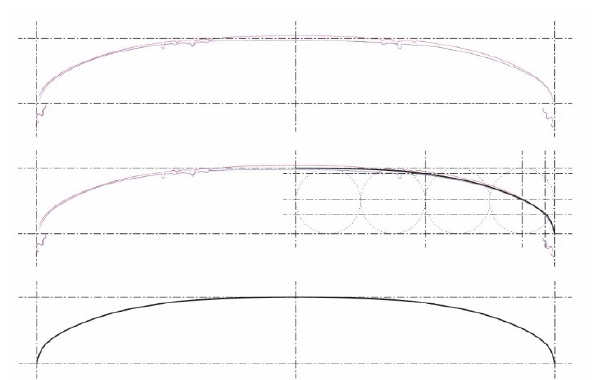
Figure 13. Tracing method for directices and comparison with the section of point cloud (red). Drawing: F. Natta The banded structure has therefore been identified starting from a main shell-like vault (I) sectioned with vertical planes (II) in order to regenerate the tripartition of each side (III). The bands considered have a width of about 57 cm, easily imaginable as consisting of two rows of bricks including mortar and plaster. By attributing a thickness of 6 cm to the bands (average value obtained from the point cloud) so as to identify the arcs on which the vaults are set, we move on to the axial vaults (IV), while the central portion is a part of the shell-like main vault. The perimeter axial and angular vaults are constructed by means of a series of parallel sections, thicker in the impost areas of the vaults (V).